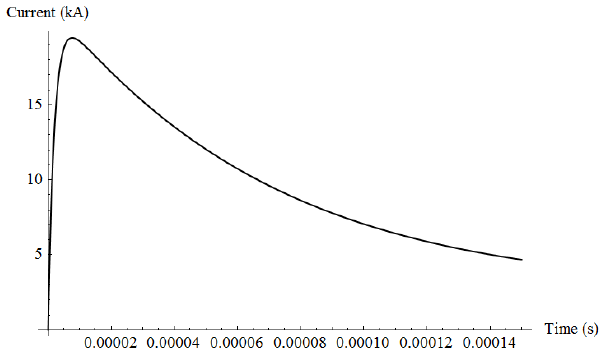
Figure 6: Electric field versus frequency at a distance of 5000 km from the source.